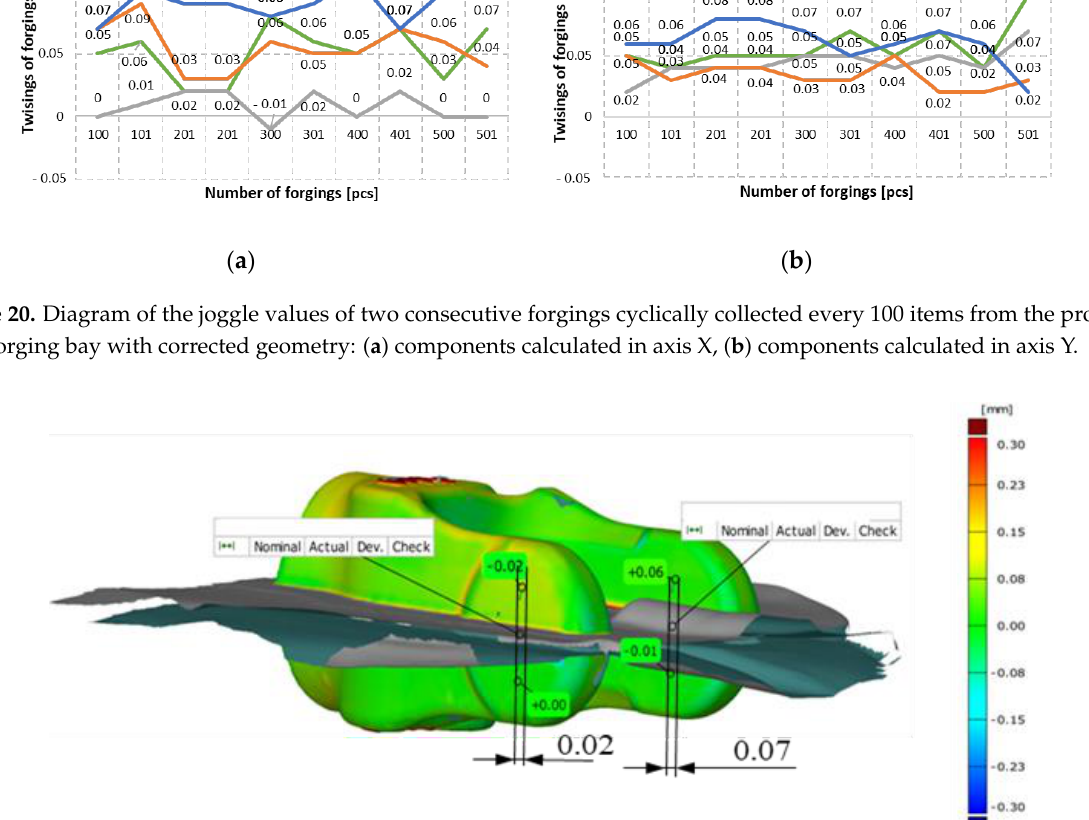
Figure 21. Exemplary results of a colour map of deviations with marked reduced joggle and twist values as a result of correctional changes in the kinematic chain.